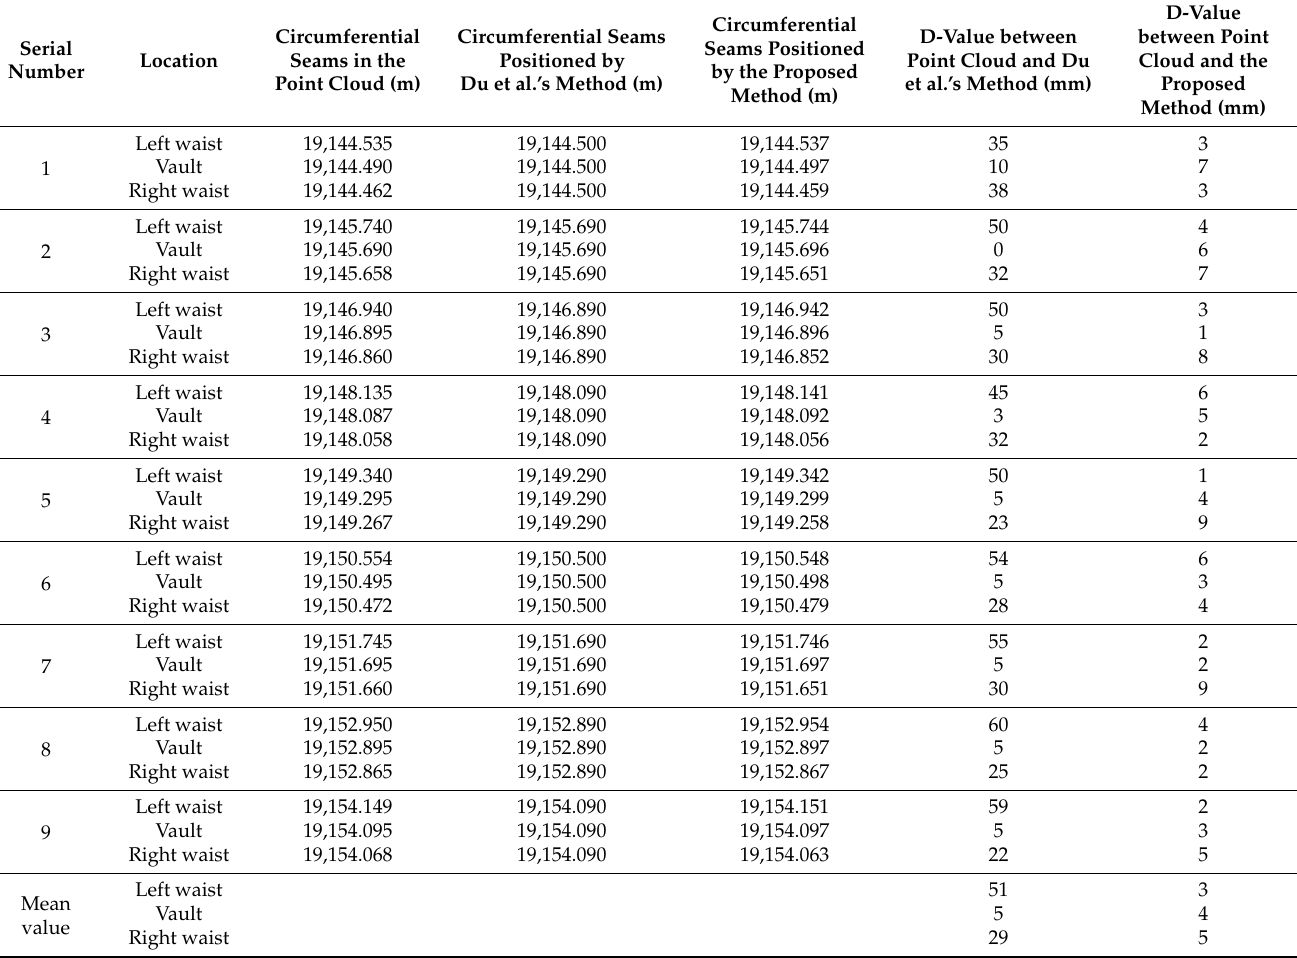
Table 4. Comparison of the original cloud seams, proposed method, and Du et al.’s method for locating